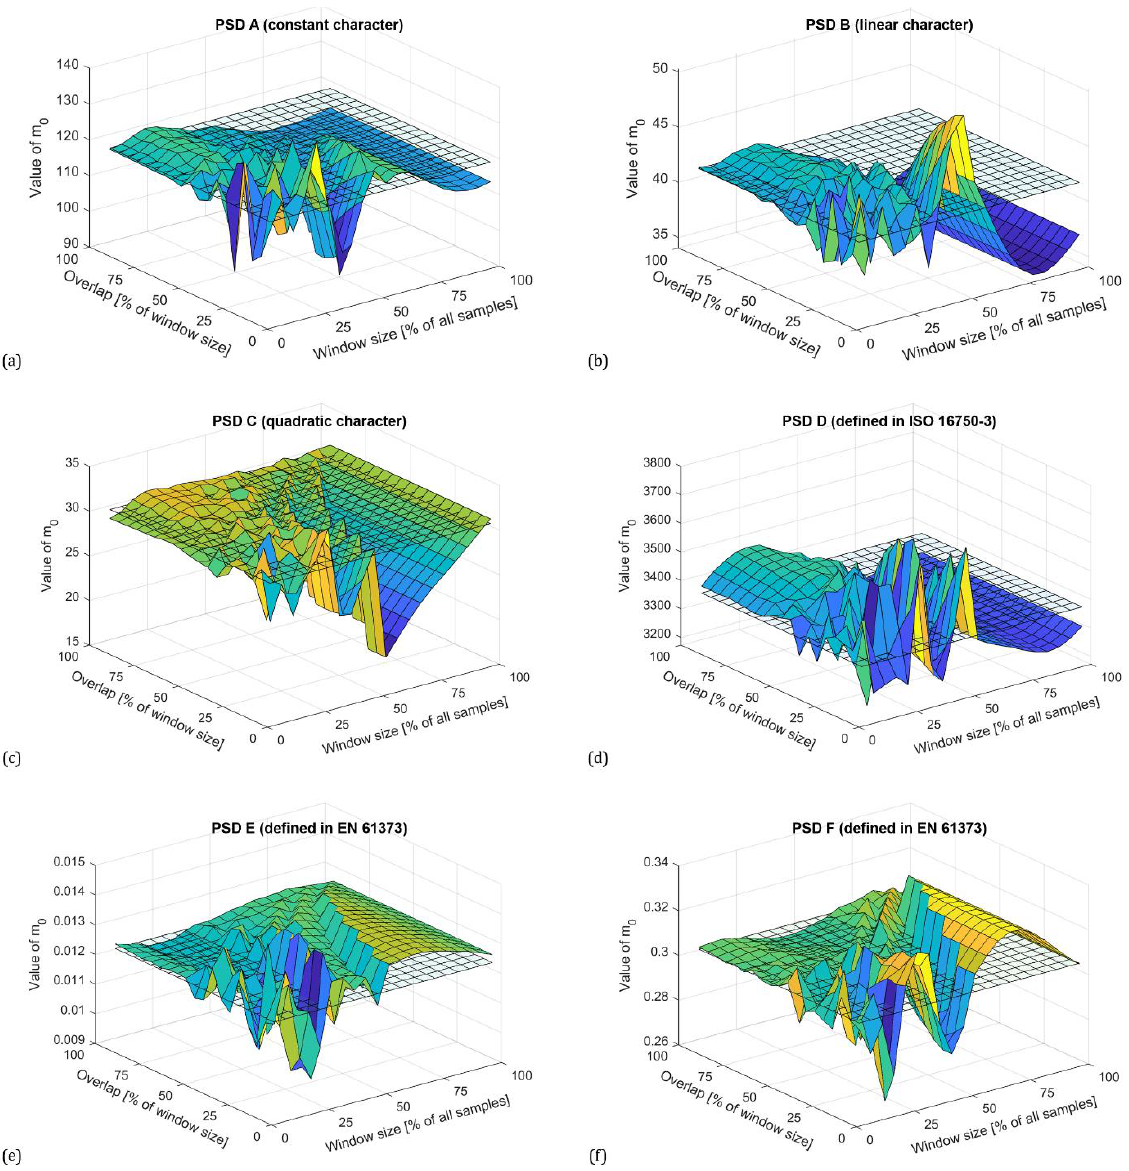
Figure 4. Zero spectral moments (variance) depending on window size and overlap for PSDs calculated with using Hamming window according to synthesized PSD using constants (a), constants with linear connection (b), and constants with quadratic connection (c), standardized PSD functions according to ISO 16750-3 (d) and EN 61373 (e)-(f).